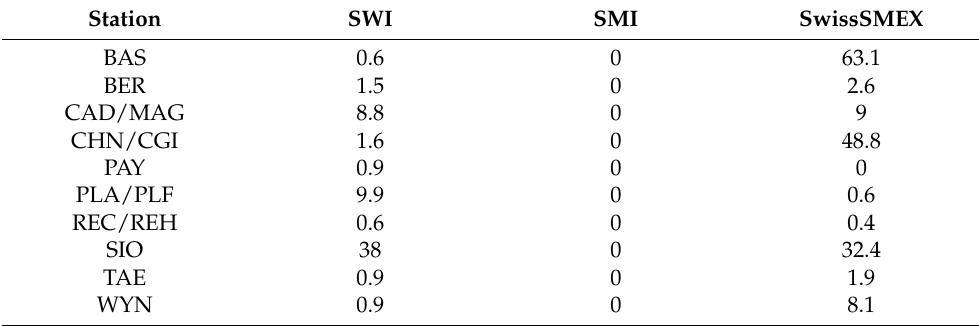
Table 2. Percentage of missing data for soil moisture datasets (analyzed period: 2011–2018, April–